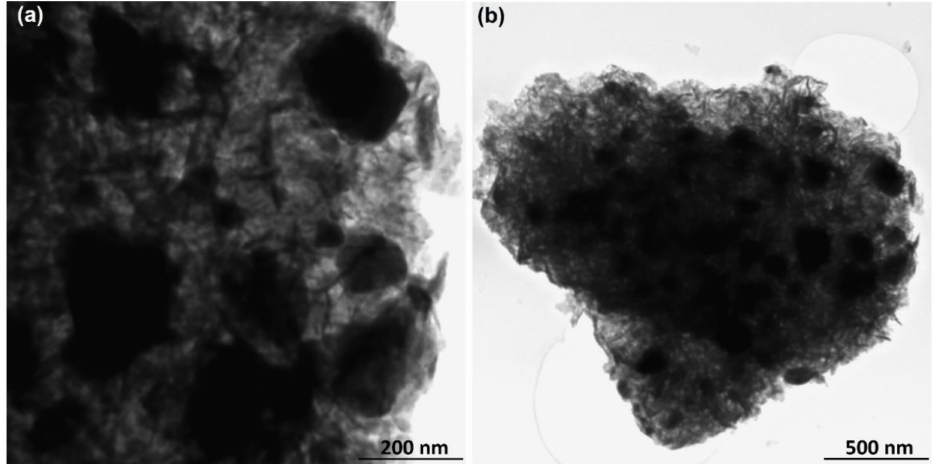
Figure 7. Transmission electron microscope (TEM) images of Ag-Cu bimetallic nanoparticles at different magnifications. ( a ) 200 nm and ( b ) 500